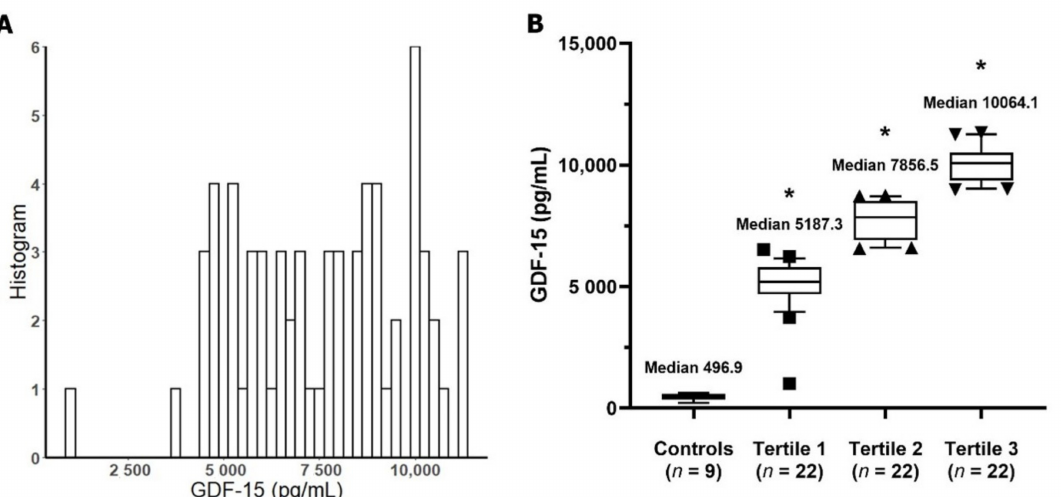
Figure 1. Growth differentiation factor-15 (GDF-15) concentrations in study patients. ( A ) Distribution of GDF-15. ( B ) GDF- 15 concentration in the tertile healthy individual groups. * p < 0.001 vs. healthy control group. Abbreviation: GDF-15, growth differentiation